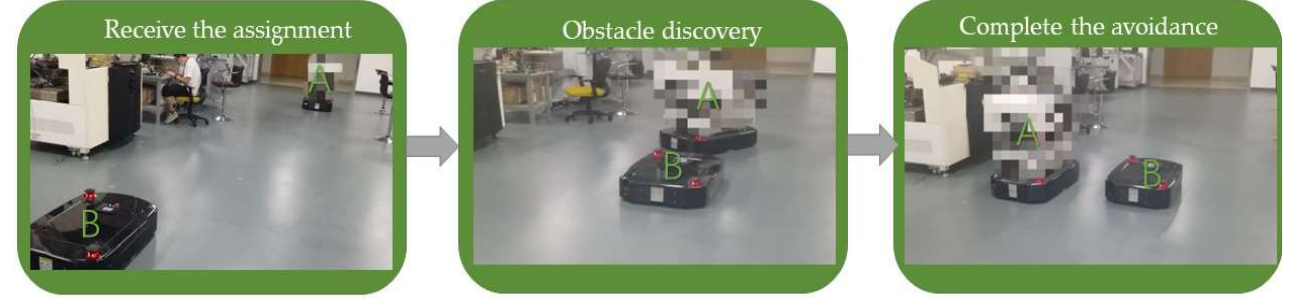
Figure 15. Frontal avoidance. A and B are the serial numbers of AGVs respectively.